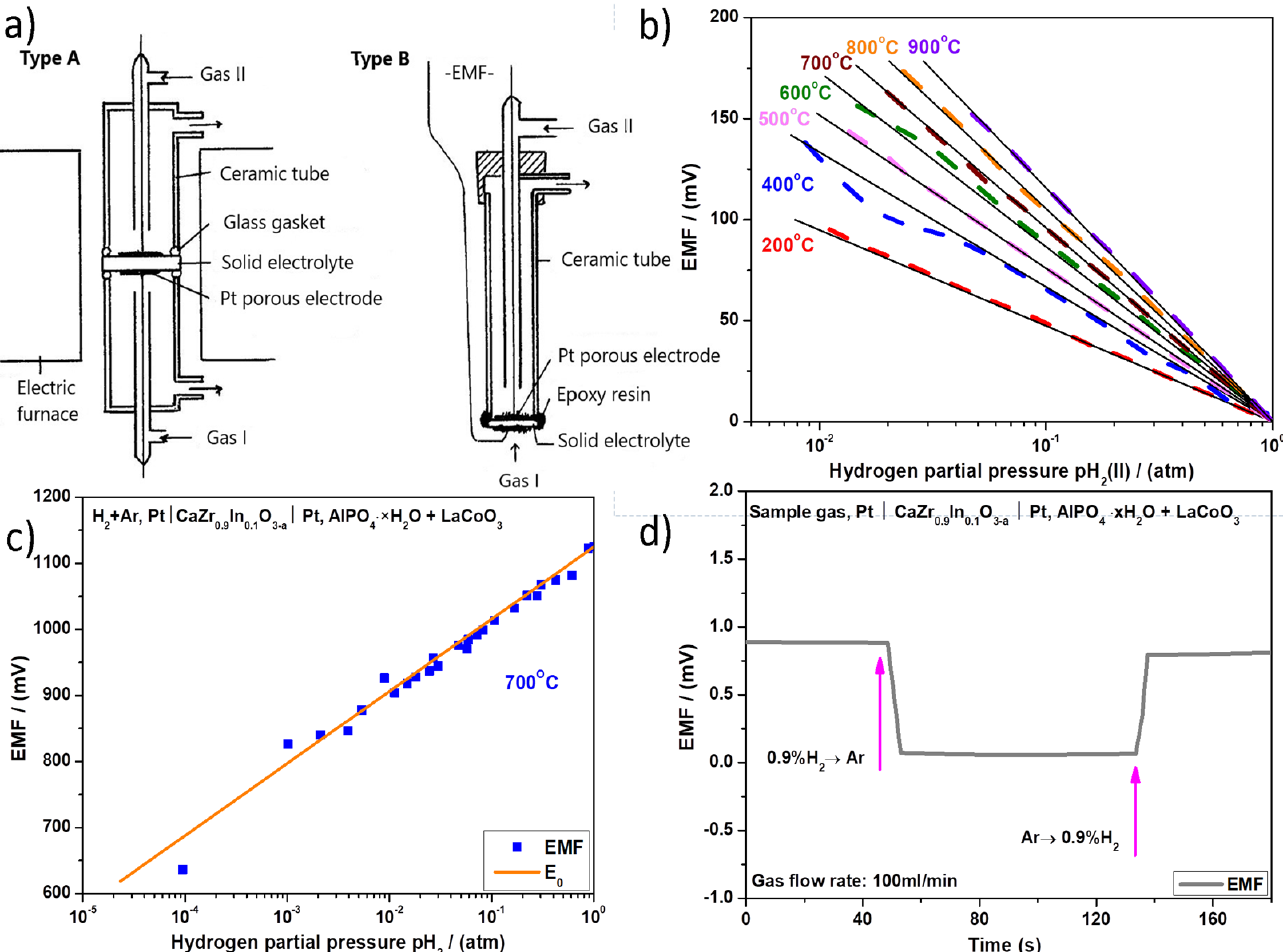
Figure 1. ( a ) Test hydrogen sensors; type A for temperatures above 400 °C and type B for tempera- tures below 400 °C. ( b ) EMF response of Pt|BCN|Pt sensor (type A sensor for T ≥ 400 °C and type B for T = 200 °C) against pH 2 (II). Solid lines show the theoretical EMF (E o ), while dashed lines cor- respond to the calculated EMF at each temperature. (Data reproduced with permission from [23].